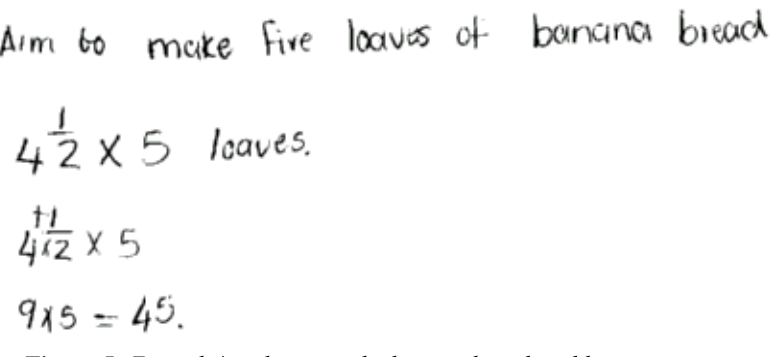
Figure 5: Zwanela’s solution to the banana bread problem